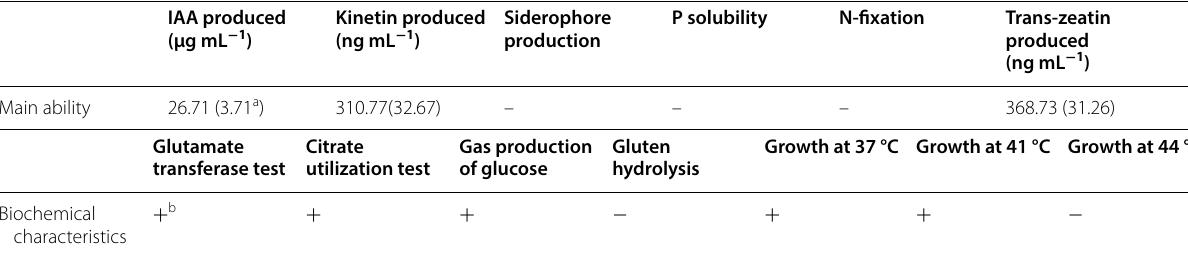
Table 1 Characteristics of physiology and biochemistry of Acinetobacter calcoaceticus